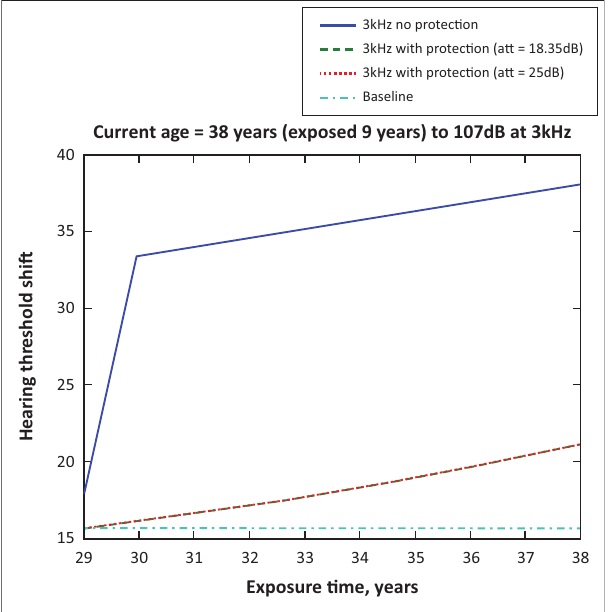
Source : Figure created using data from Moroe, N.F. (2018). Occupational noise-induced hearing loss in South African large scale mines: From policy formulation to implementation and monitoring . Doctoral thesis. Johannesburg: University of the Witwatersrand. FIGURE 10: Fifty-five years old at 3000 Hz with exposure levels of 110